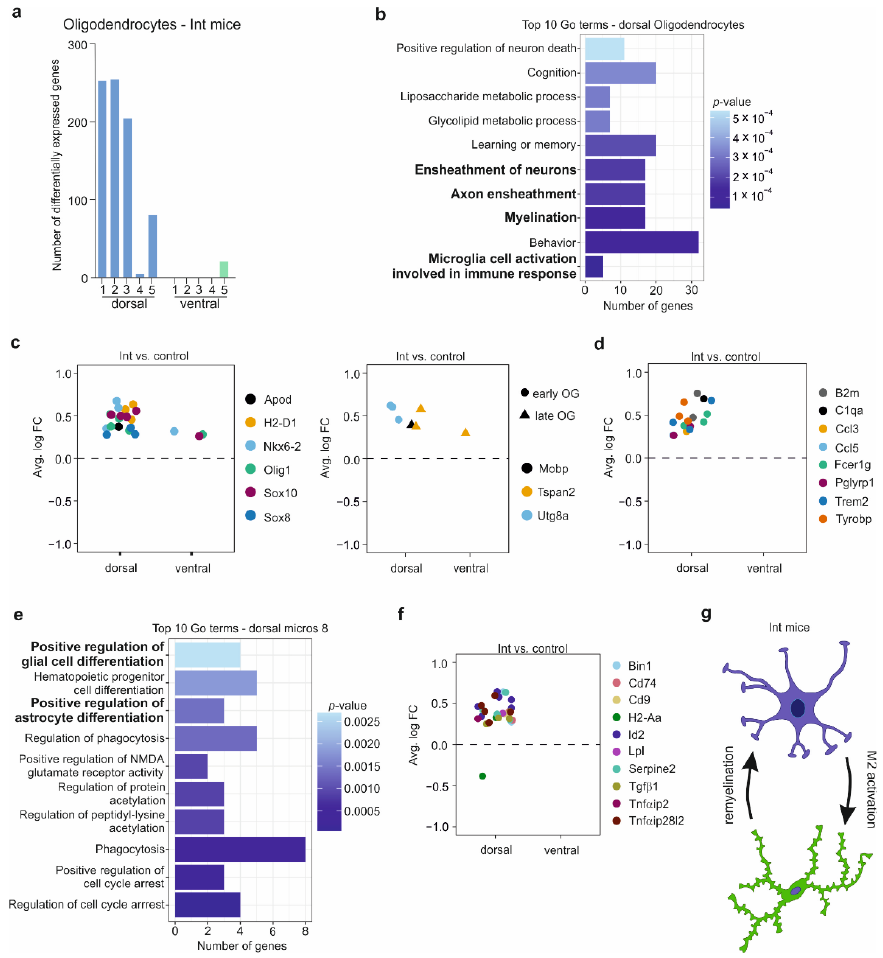
Figure 4. Chronic social defeat stress induces an oligodendrocyte response in the hippocampal dorsal part in the intermediate mice. ( a ) Number of DEGs among the oligodendrocytes sub-clusters 1 to 5 in the intermediate mice compared to control mice in the dorsal and ventral parts of the hippocam- pus. ( b ) Top 10 GO terms analysis related to the DEGs identified in the dorsal hippocampus of the intermediate mice. The most relevant pathways are highlighted in bold. ( c ) Differential expres- sion of the oligodendrocyte progenitor (left panel), early and mature (right panel) oligodendrocyte markers in the intermediate (Int) mice compared to control mice in the dorsal and ventral parts of the hippocampus. ( d ) Differential expression of oligodendrocyte genes involved in microglia cell activation participating in the immune response pathway in the intermediate mice compared to control mice in the dorsal and ventral parts of the hippocampus. ( e ) Top 10 GO terms analysis re- lated to the DEGs identified in the dorsal hippocampus of the sub-cluster micros_8 of the interme- diate mice. The most interesting pathways are highlighted in bold. ( f ) Differential expression of the genes involved in the positive regulation of the glial cell differentiation pathway in the microglia cluster in the intermediate mice compared to control mice in the dorsal and ventral parts of the hippocampus. ( g ) Proposed cell-cell interaction identified in the intermediate mice between oli- godendrocytes (top) and microglia (bottom).